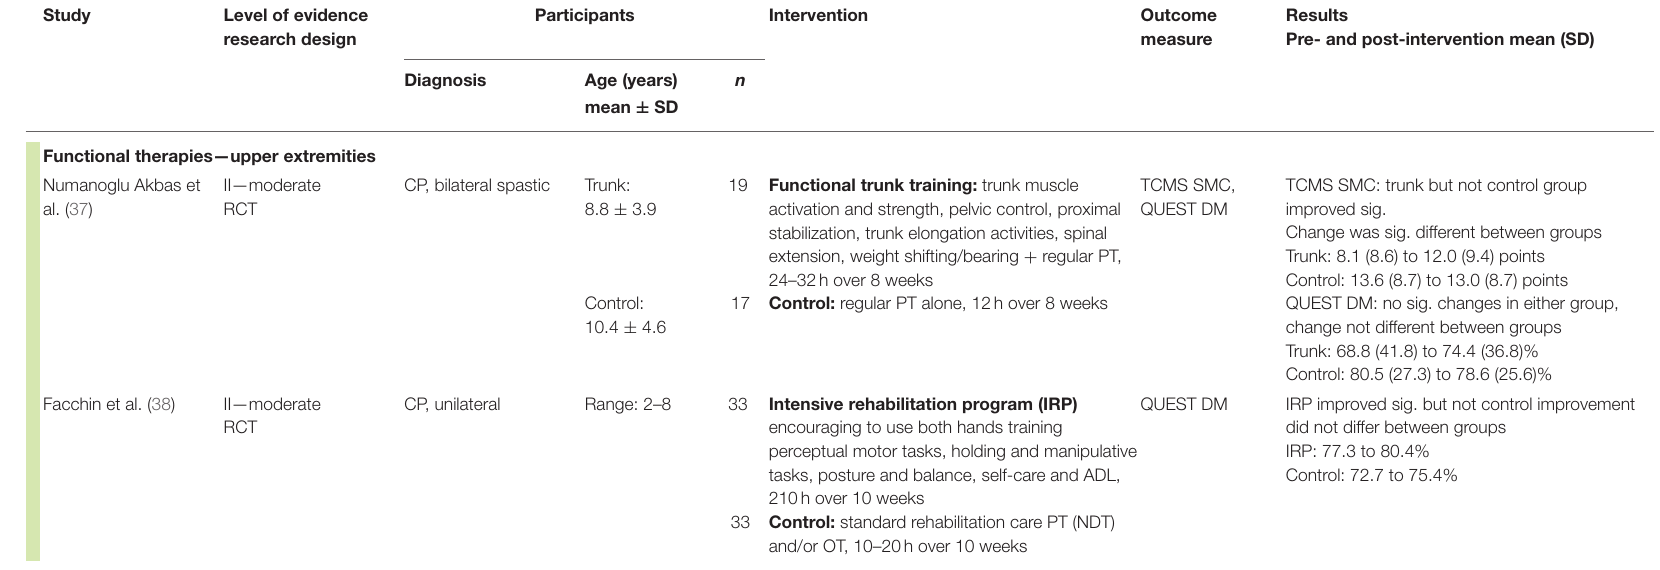
QUEST DM IRP improved sig. but not control improvement did not differ between groups IRP: 77.3 to 80.4% Control: 72.7 to